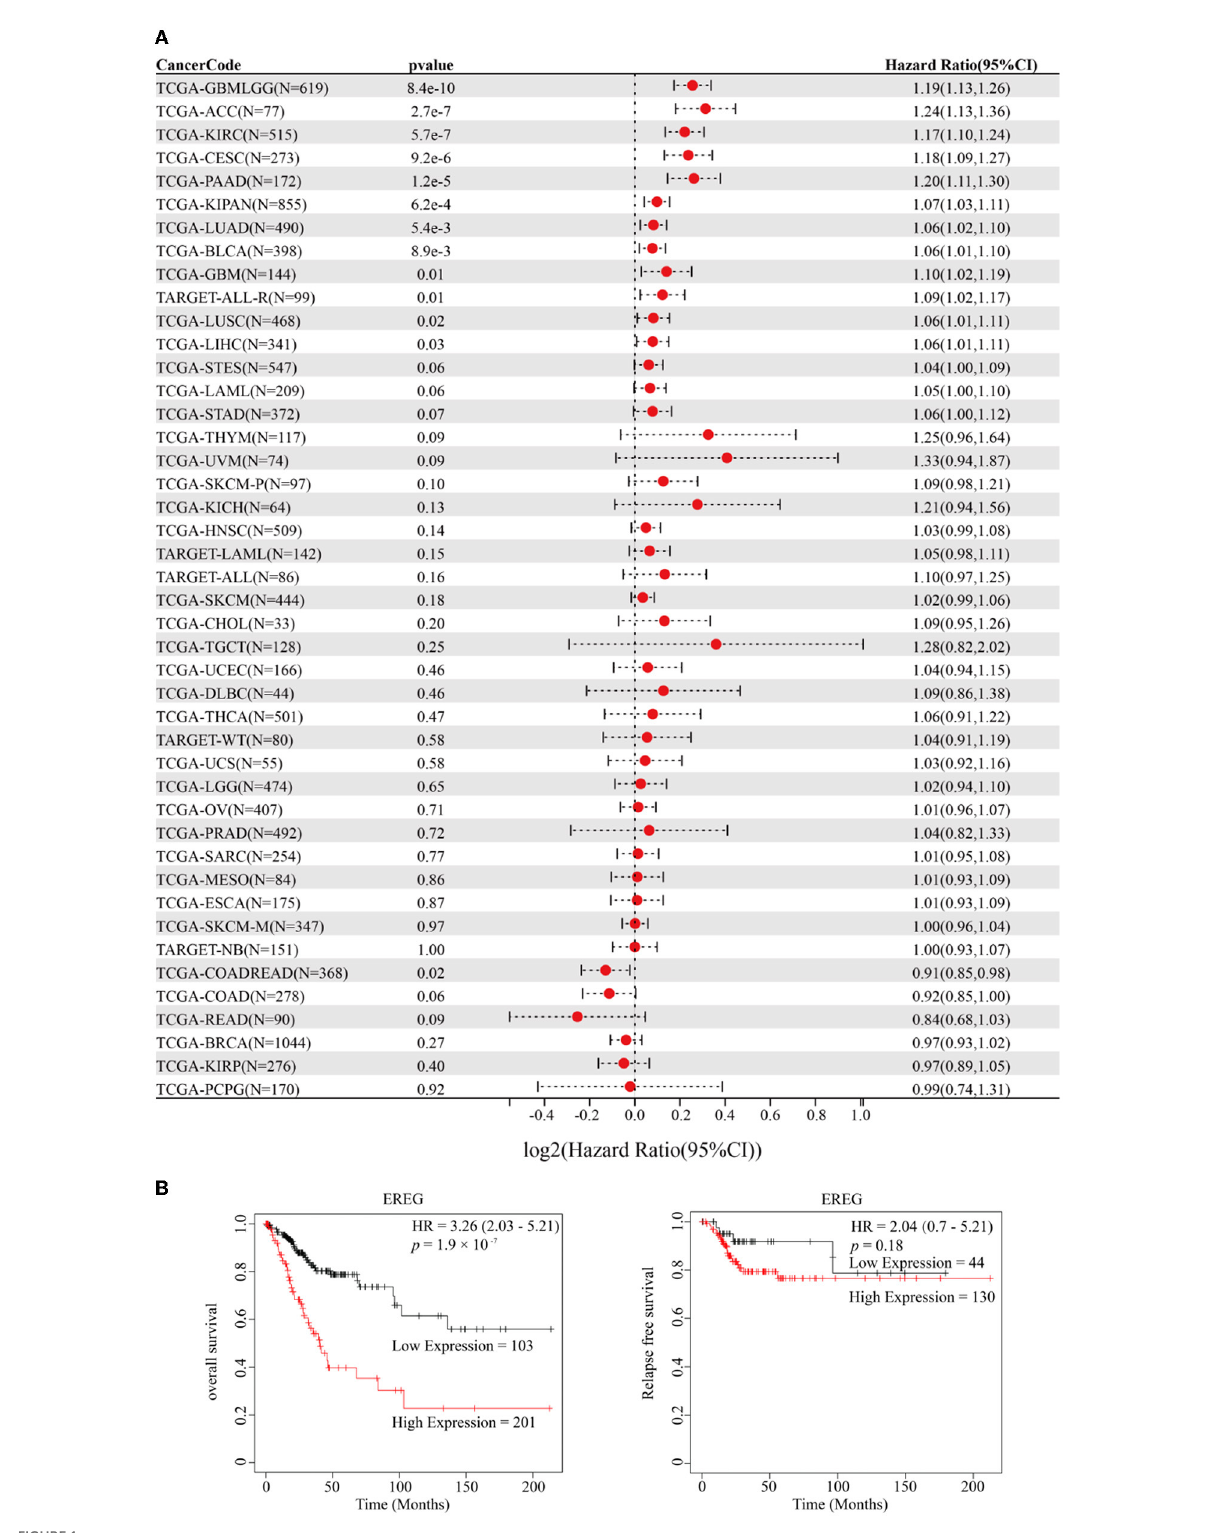
FIGURE1 Prognosis analysis of EREG in Pan-Cancer and patients with cervical cancer. (A) The forest map delineated the relationship between EREG expression and overall survival in 44 types of cancer. The cancer codes and corresponding full terms are listed in Supplementary Table 1. (B) The overall survival and relapse-free survival of EREG in patients with cervical squamous cell carcinoma and endocervical adenocarcinoma were presented by Kaplan–Meier Plotter